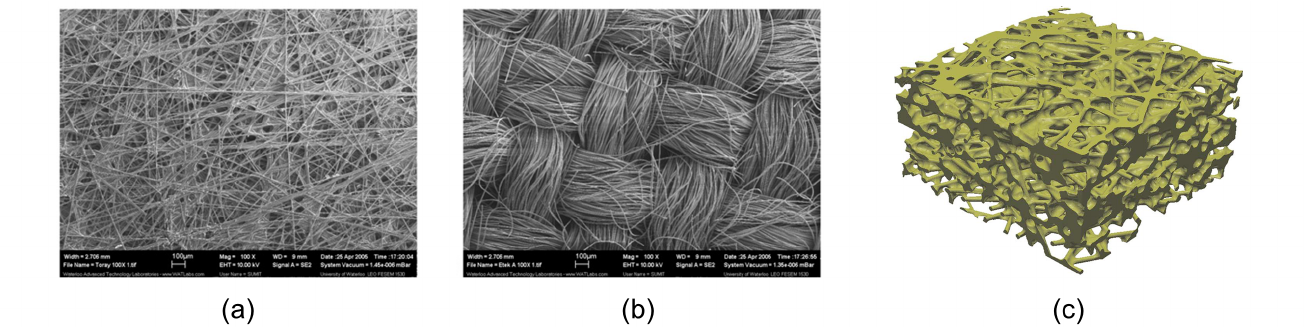
Figure 11. Two different GDL fabrication types: ( a ) carbon paper (Toray 090) and ( b ) woven carbon cloth (E-Tek Cloth “A”) (reprinted from the work in [50]). ( c ) Reconstructed 3D view of GDL structure of uncompressed carbon paper using phase contrast tomographic microscopy. Reprinted from the work in